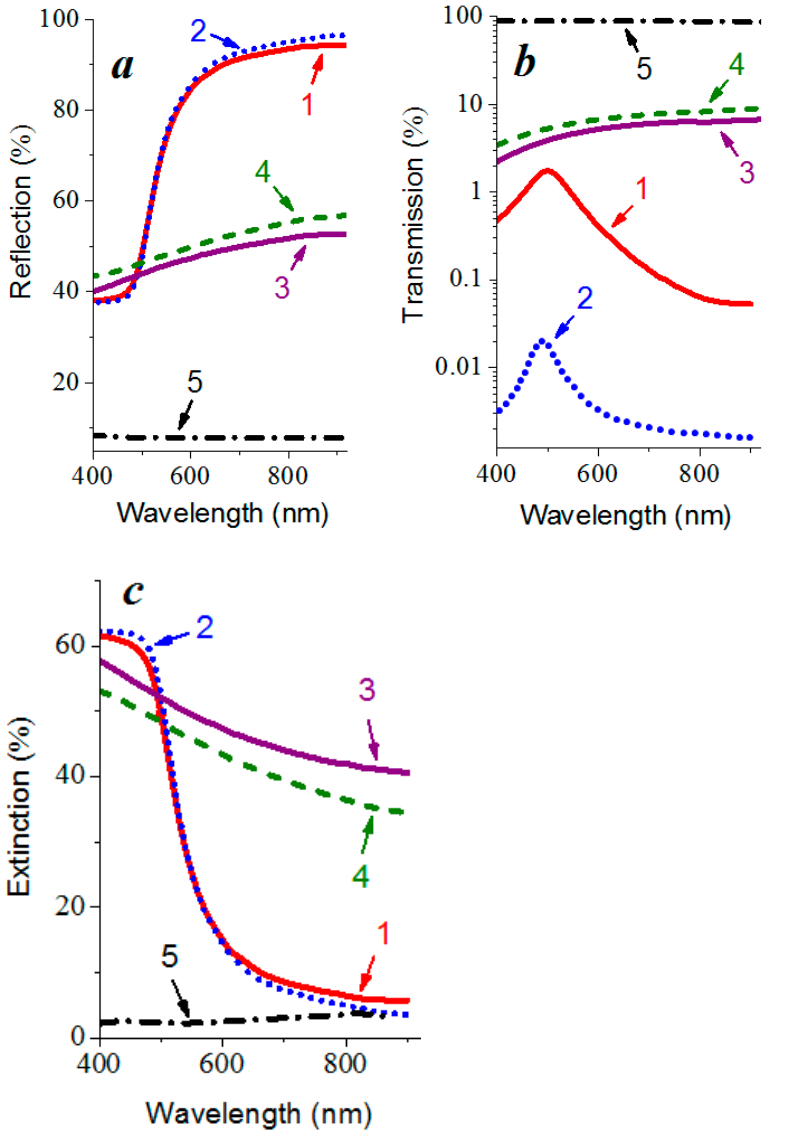
Figure 7. Reflection ( a ), transmission ( b ), and extinction ( c ) spectra of gold (1) and (2) and beryllium (3) and (4) films on quartz obtained by single deposition (1) and (3) and by multiple deposition–sputtering (2) and (4) and the corresponding spectra of quartz (5). Extinction spectra were built on the base of the reflection and transmission spectra.